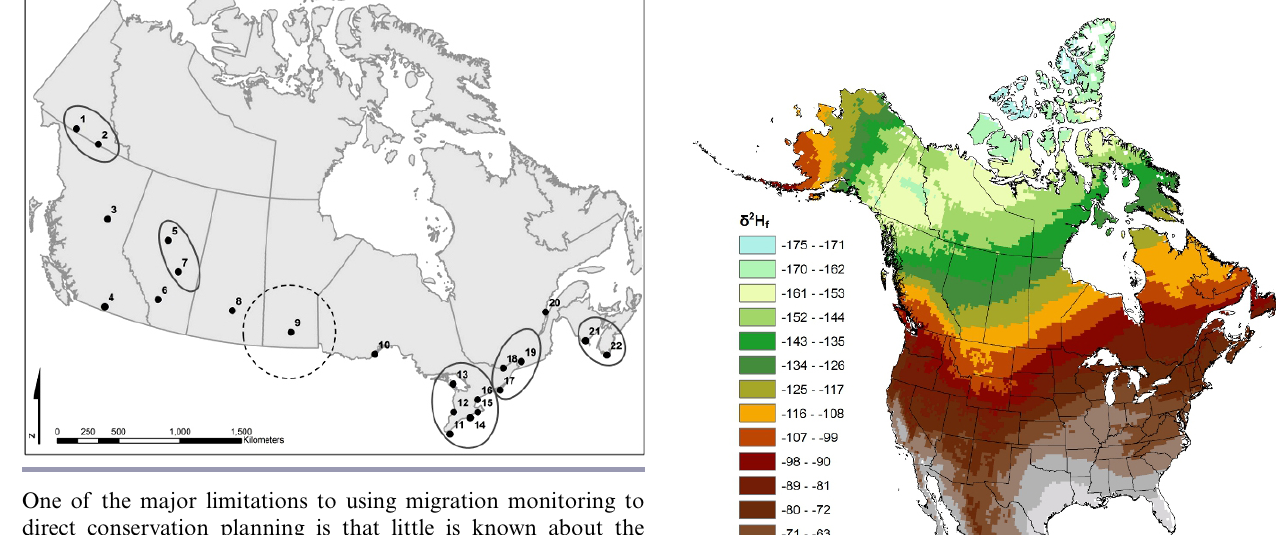
Fig. 2 . Predicted hydrogen isotope ratios of feathers ( δ ²H ) for f North American passerines, calibrated from the amount- weighted mean growing season stable-hydrogen isotope ratio in precipitation ( δ ²H ) isoscape of Bowen et al. (2005). Known p source feather samples (Clark et al. 2006, 2009) were used to derive the rescaling equation used to convert the δ ²H isoscape p to a δ ²H isoscape based upon the equation δ ²H = -25.9 + 0.88 f f (see δ ²H p